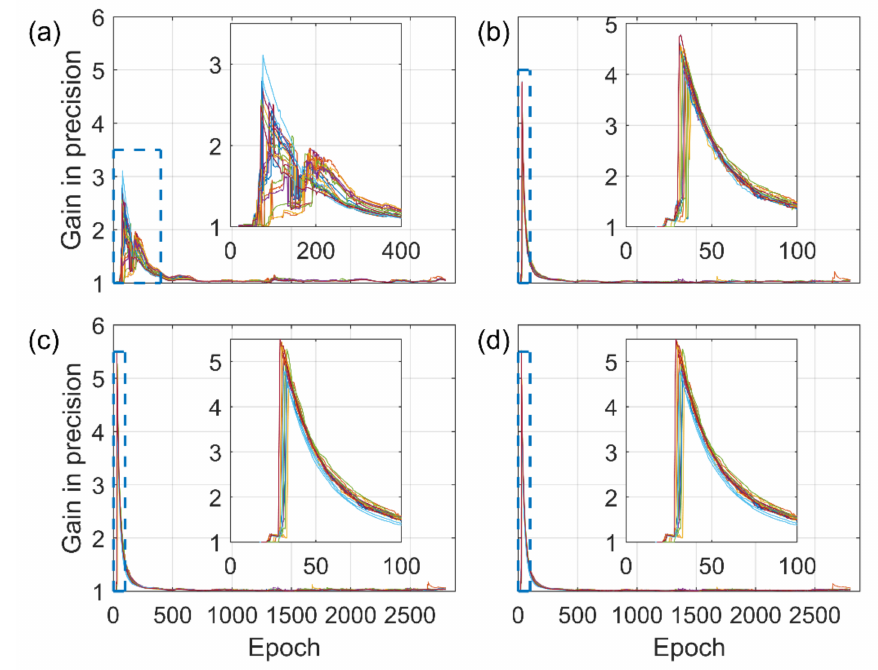
Figure 5. Gain in 3D precision of the four multi-GNSS combing cases with ( a ) GPS only, ( b ) GE, ( c ) GEC, and ( d ) GECR. Each line represents one user